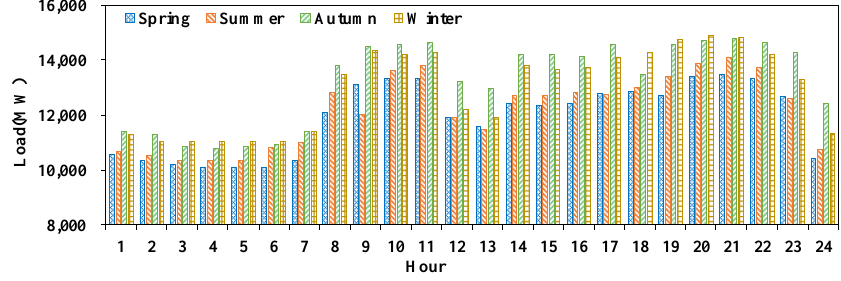
Figure 6. Typical load curves in different season.